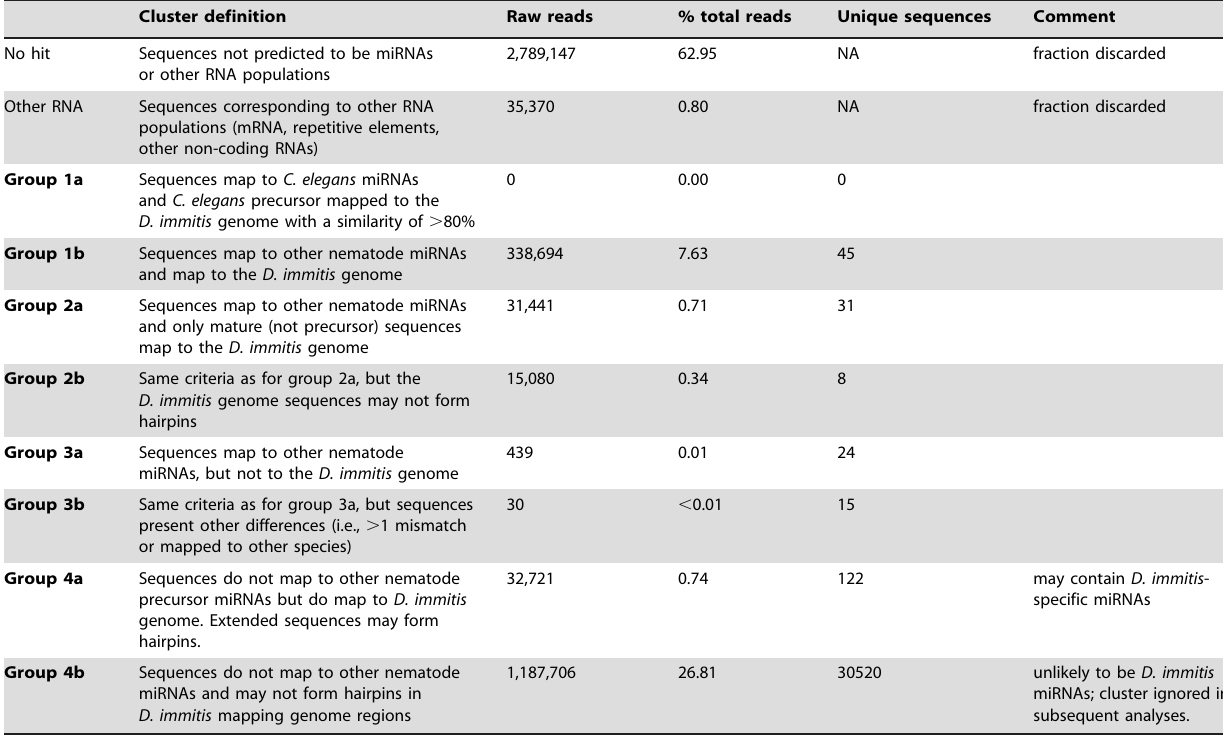
Table 1. Unique sequence